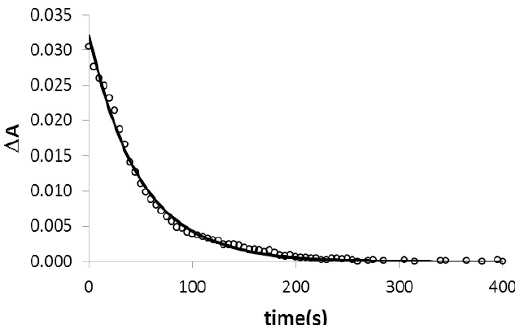
Figure 5. Absorbance decay recorded at 15 °C in 20% EtOH (symbols). The decay was obtained by measuring the absorbance at 270 nm as a function of time after adding to a cell containing the hairpin at 1.1 µ M an equimolar amount of TFO RNA 1. The decay curve was fitted to previously developed equations [43] to determine the association and dissociation rate constants (continuous line).